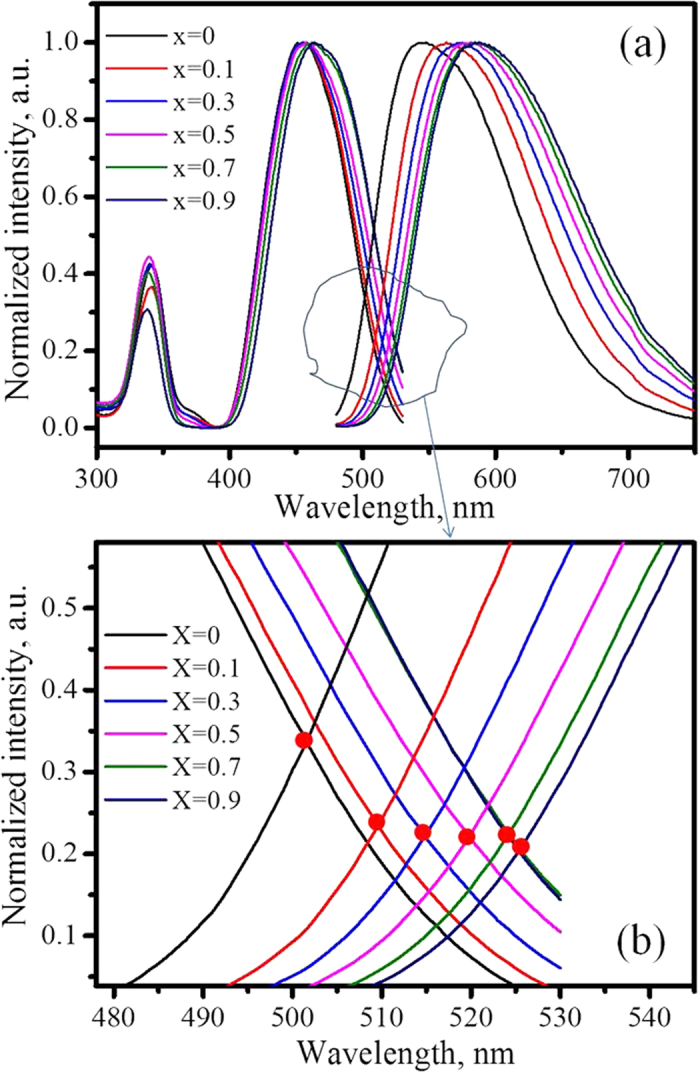
The emission and excitation spectra of (Y1−xGdx)2.94Al5O12: 0.06Ce3+ with normalized intensity(a) and the amplified region showing the crossover of the emission and excitation upon different amount of Gd3+.